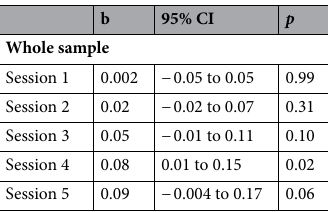
Table 3. Behavioural performance in implicit learning as measured by MCC, controlled for age and IQ. CI confidence interval, b beta coefficient of task performance during training session